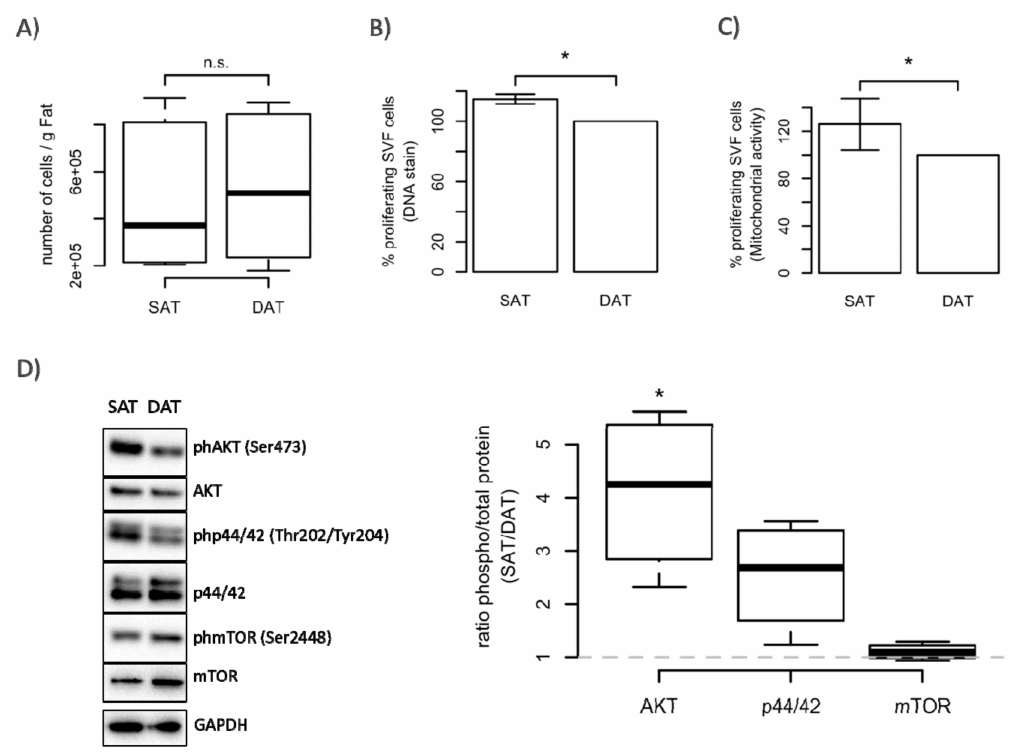
Figure 2. Stromal vascular fraction (SVF) cellularity and proliferation capacity of SAT- and DAT-derived adipose-derived stem cells (ASC). ( A ) Cellularity was calculated by correlating the numbers of SVF cells with the amount (g) of processed fat tissue. Data are shown as mean ± SD ( n = 6); ( B , C ) proliferation of SAT and DAT ASC was assessed after culture for 6 days by analysing DNA content (CyQANT) and mitochondrial activity (PrestoBlue). Results are shown as % of DAT (set to 100%) from six patients; ( D ) representative immunoblot and quantitative assessment of day 3 proliferating ASC from four donors, analysing expression and phosphorylation of protein kinase B (AKT), extracellular signal-regulated kinase ERK 1/2 (p44/42), mammalian target of rapamycin (mTOR), and GAPDH as loading control. Data are shown as mean ± SD. Significance for difference of the means was calculated using a paired t -test (* p -value <